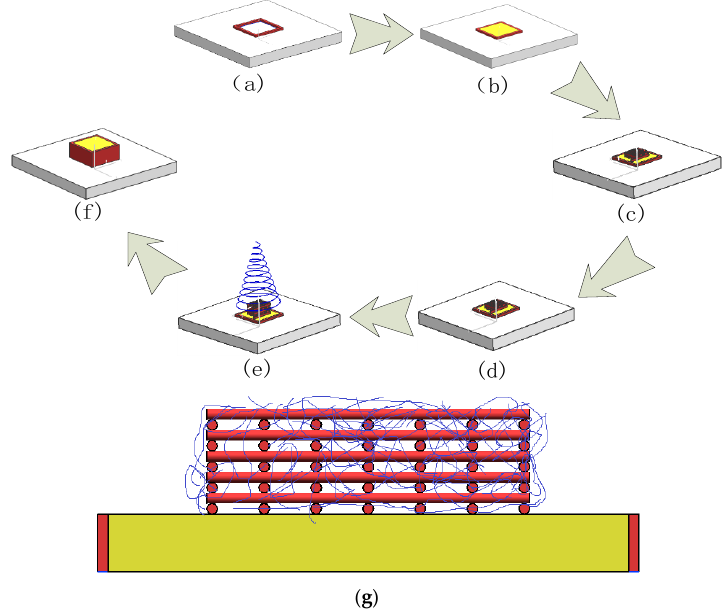
Figure 2. Process for the fabrication of constructs with multiscale channels: ( a ) patterned ring structure; ( b ) liquid gelatin solution poured into patterned ring structure to form base; ( c ) first layer of sacrificial material was printed on the base; ( d ) second layer of sacrificial material printed on first layer; ( e ) electrostatic spinning process after completing 6 layers; ( f ) complete ring structure and pouring of liquid gelatin solution into patterned ring structure; and ( g ) sectional view before encapsulation.